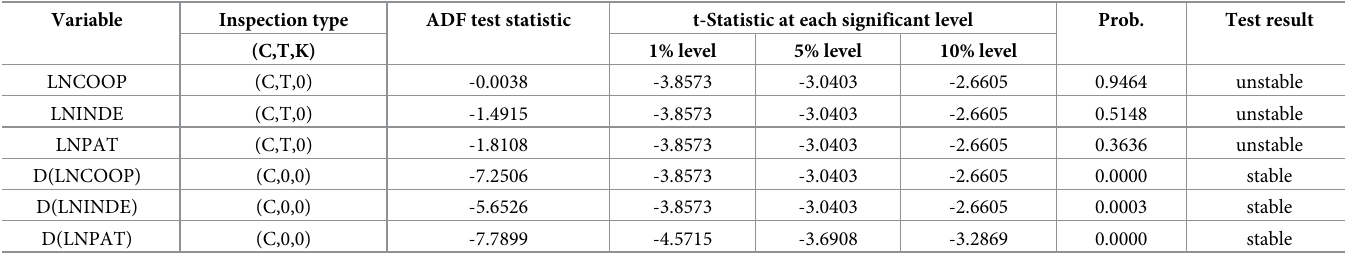
Table 3. LNCOOP, LNINDE, LNPAT, and their first difference ADF results.